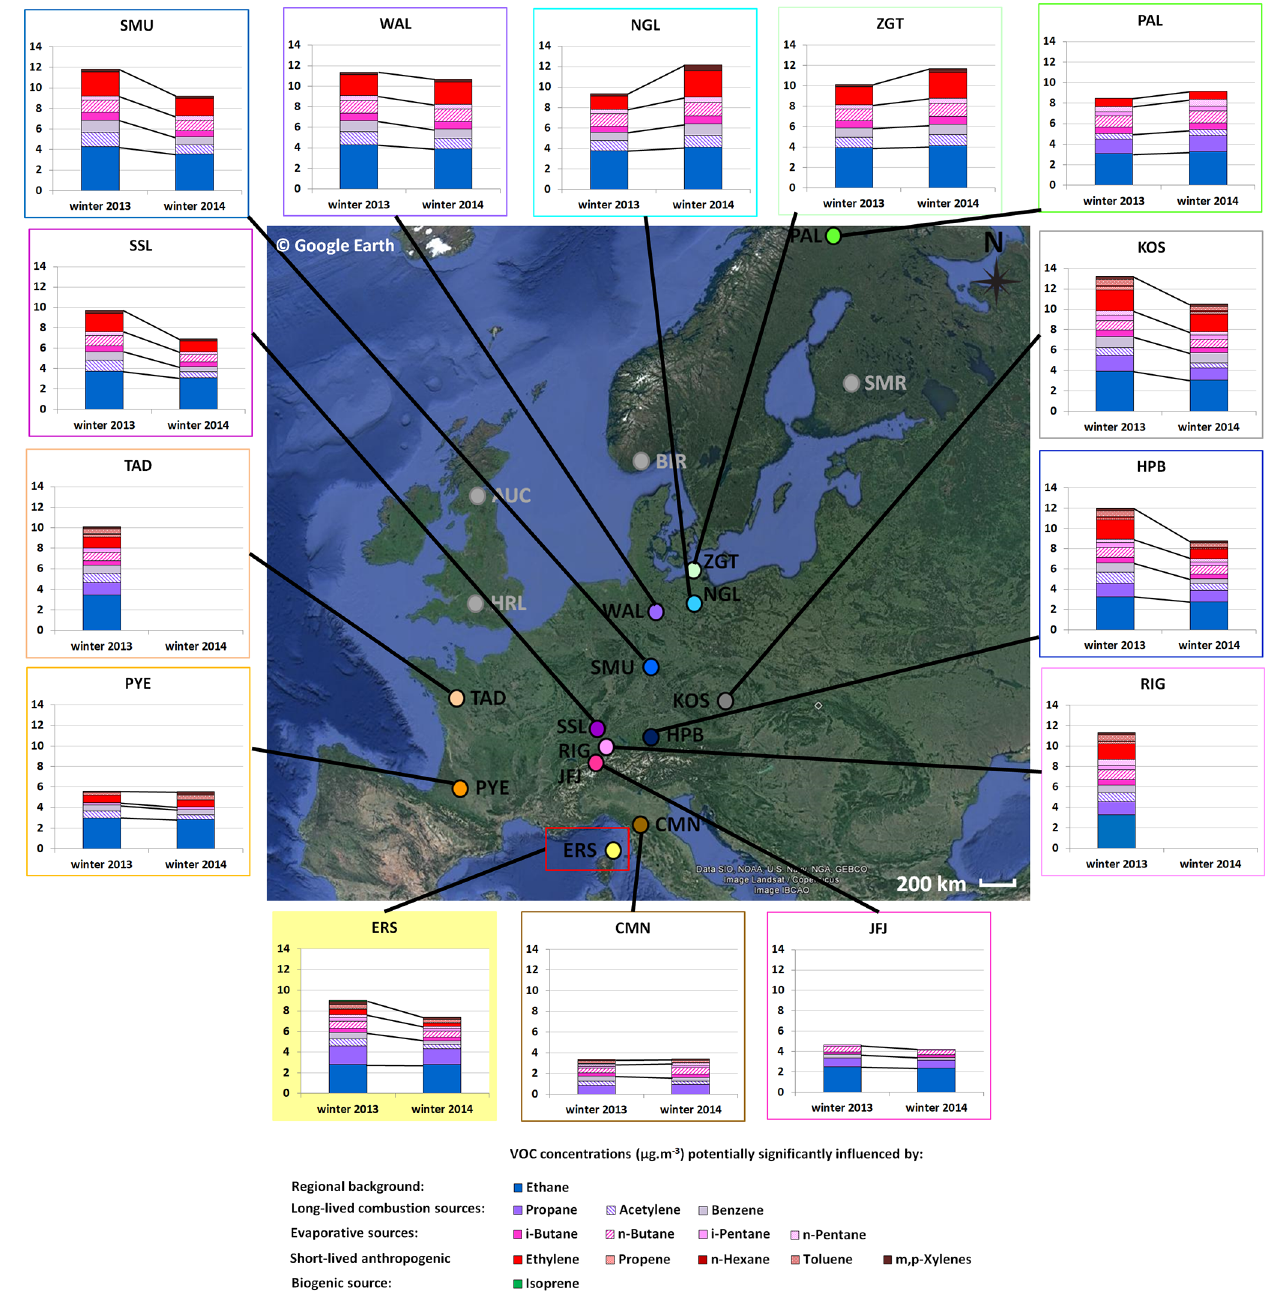
Figure 14. Average accumulated concentrations of a selection of 15 VOCs (expressed in µgm − 3 ) measured at Ersa and 13 other European monitoring stations in winters 2013 and 2014. Stations are indicated according to their GAW identification (see Sect. S7). “ERS” refers to the study site and its location and results are highlighted. Selected VOCs are those taken into account in the factorial analysis of this study. Note that NMHC measurements did not cover the winter 2014 period at the TAG and RIG stations. For the AUC, HRL, BIR and SMR stations, represented by grey markers, NMHC measurements were not realized both during winters 2013 and 2014 or were conducted with a PTR-MS, and hence we considered accumulated concentrations only of aromatic compounds to be not sufficiently representative of interannual variations in NMHC winter concentrations. Map provided by Google Earth Pro software (v.7.3.3 image Landsat/Copernicus